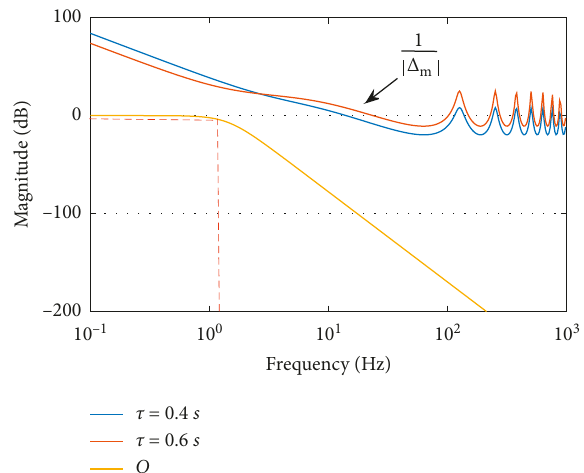
Figure 13: The verification of the Q-filter design requirement.